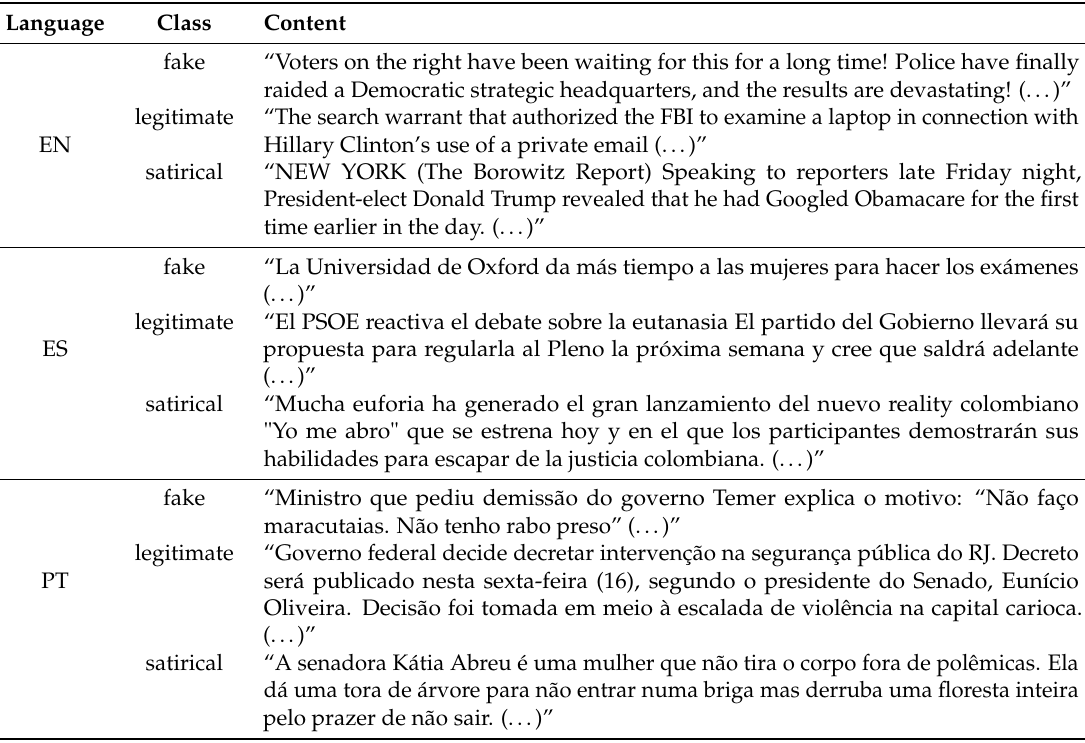
Table 3. Examples of news content for all classes of each